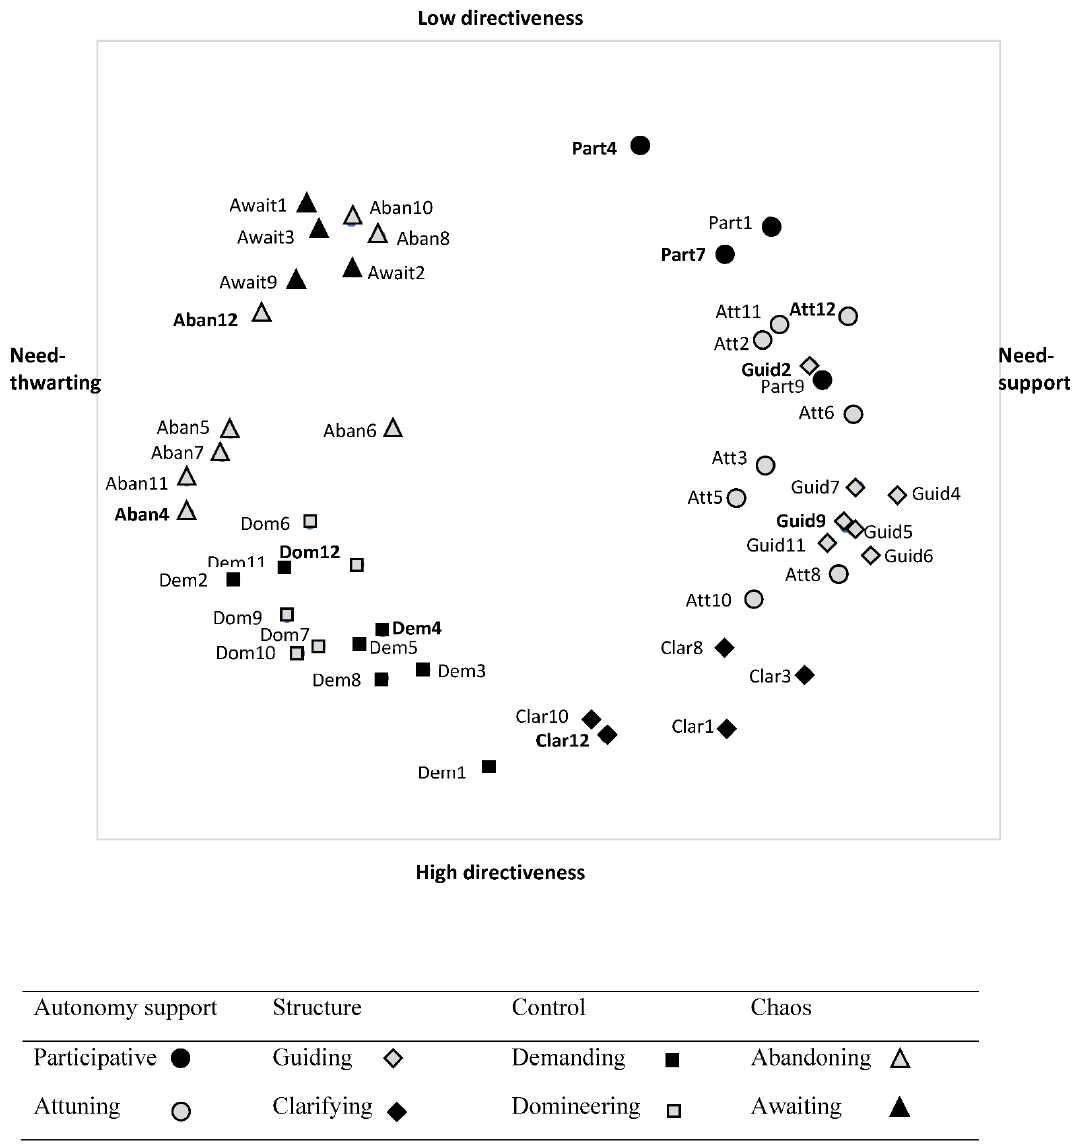
Figure 2. Two-dimensional representation of the simulations-in-schools–physical education (SIS-PE) items in Belgium and France.